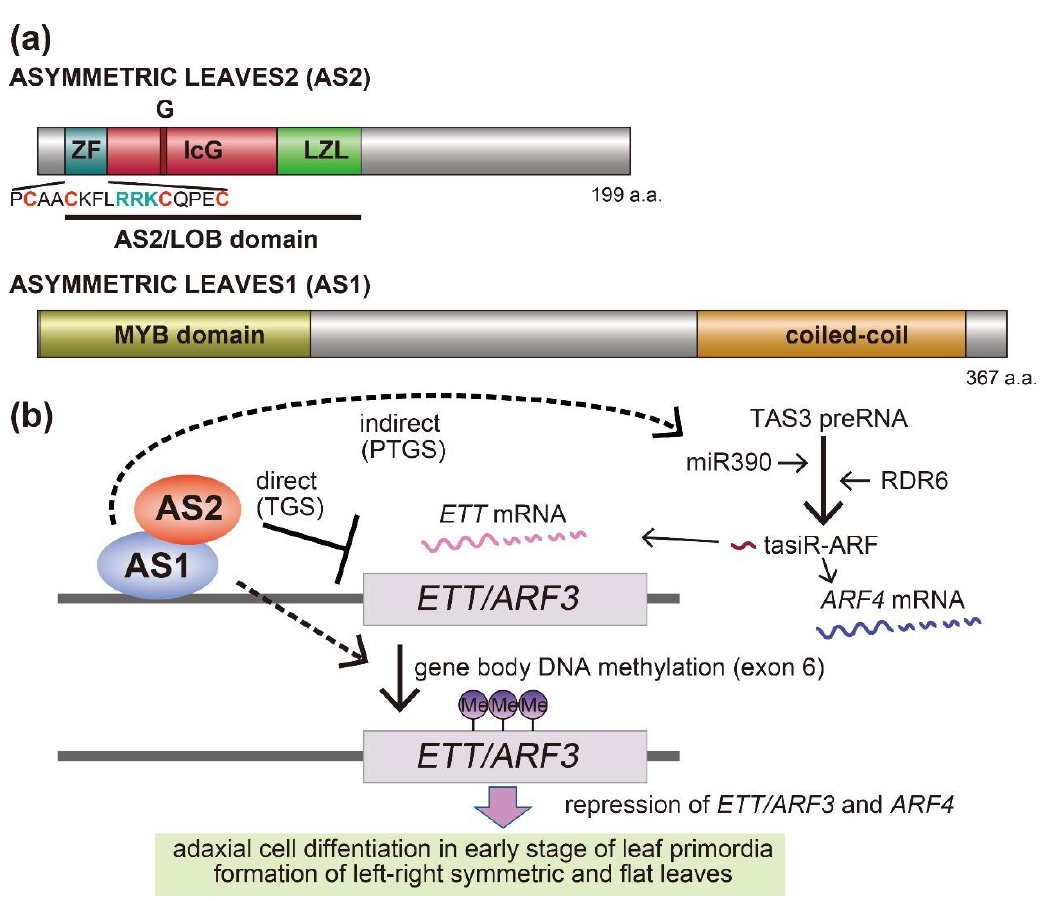
Figure 2. ( a ) Motif and domain organization of AS2 and AS1 proteins. The ZF motif, IcG, and LZL regions of AS2 and the MYB domain and coiled-coil structure of AS1 are shown. ( b ) Dual regulation of ETT / ARF3 gene expression, including that by the possibly epigenetic system of AS2–AS1. The AS2–AS1 complex represses ETT / ARF3 directly by binding to its promoter and represses ETT / ARF3 and ARF4 indirectly via stimulation of the miR390 and tasiR-ARF pathway. In addition, AS1 and AS2 maintain gene body DNA methylation of the ETT / ARF3 gene. Solid lines indicate direct regulation and dashed black lines indicate indirect regulation. Schemes of (b) are modified from ref. [2].